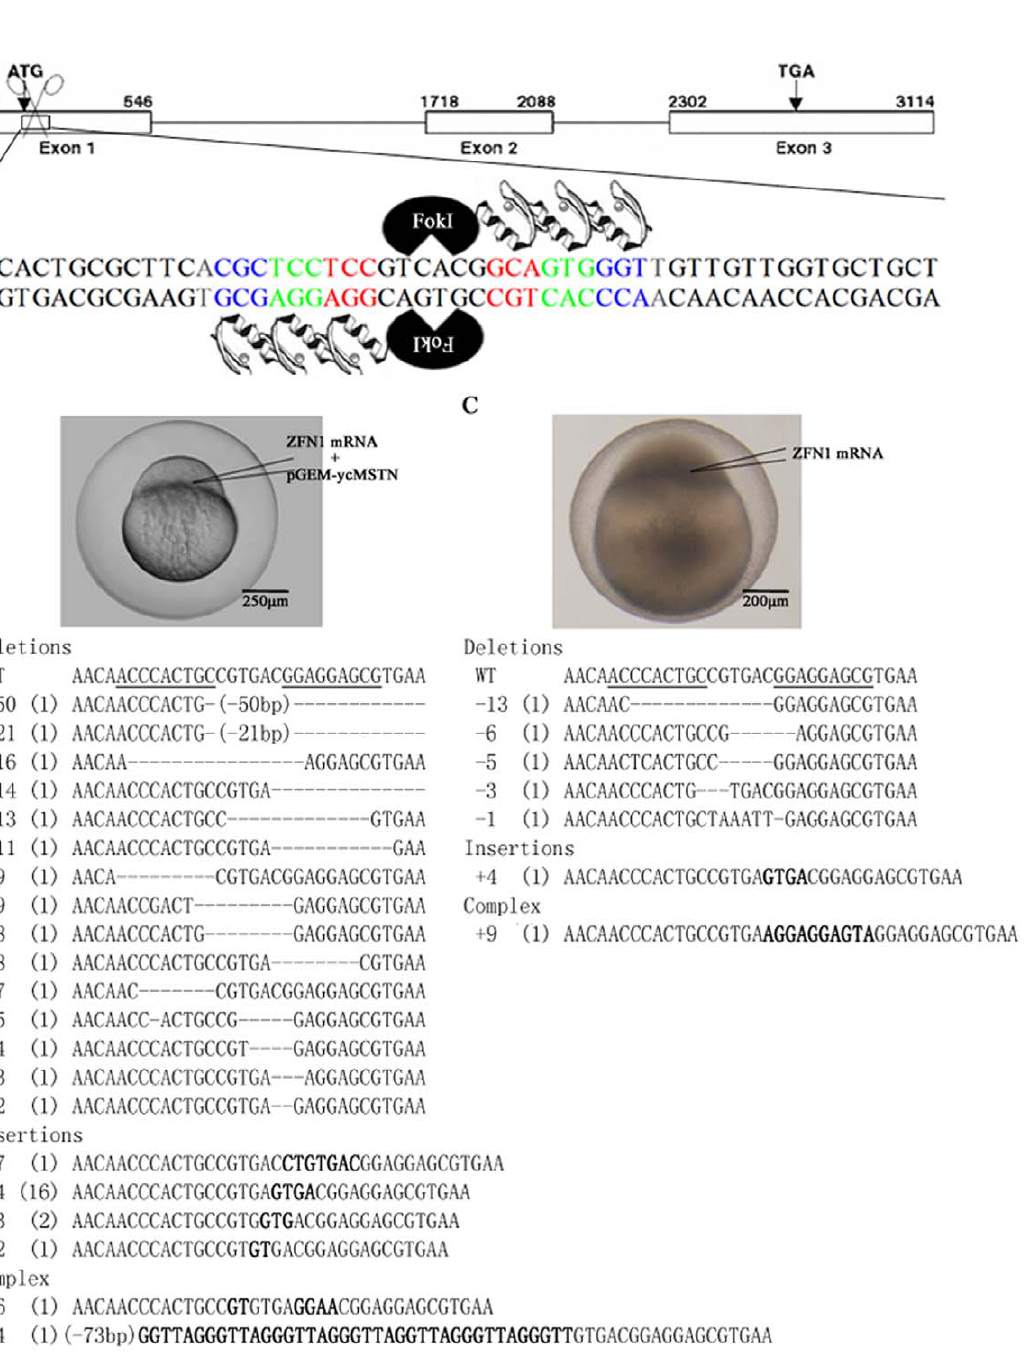
Figure 1. Zebrafish embryos can be used as an invivo system to examine ZFN activity of editing yellow catfish mstn gene. (A) Schematic diagram shows ZFN1 binding to the yellow catfish mstn gene. Yellow catfish mstn exons are shown as boxes and its introns are shown as solid lines. Start codon (ATG) and stop codon (TGA) are marked in exon 1 and exon 3, respectively. Number above the exon box denotes the position of nucleotides in the gene [4]. The ZFN1 binding site is in exon 1. The triplets of nucleotides recognized by ZFN1 fingers are marked in different colors. (B) Zebrafish embryos were used as an in vivo system to examine ZFN activity of editing yellow catfish mstn gene. The plasmid containing exon 1 of yellow catfish mstn gene (pGEM-ycMSTN) was co-microinjected with ZFN1 mRNA into zebrafish embryos at 1–2-cell stage. The mstn molecules were amplified from the zebrafish embryos at 24 hpf and then subcloned for sequencing. Analyses on sequences of the molecules revealed that the molecules of disrupted mstn were categorized into three groups including deletions, insertions and complex. (C) ZFN1 cut mstn in yellow catfish genome. ZFN1 mRNA was microinjected into yellow catfish embryos at 1–2-cell stage. The mstn molecules were amplified from the yellow catfish embryos at 72 hpf and then subcloned for sequencing. Analyses on sequences of the molecules revealed that the molecules of disrupted mstn in yellow catfish genome were categorized into three groups including deletions, insertion and complex. WT: partial sequence of wild type mstn containing ZFN1 targeting site (B, C). Number in the leftmost of the panels (B, C) shows the number of nucleotides was deleted ( 2 ) or inserted ( + ) in the mutated mstn gene. Number in the bracket shows the frequency of the mutated molecules (B, C). Inserted nucleotides are bolded (B, C). doi:10.1371/journal.pone.0028897.g001 PLoS ONE |